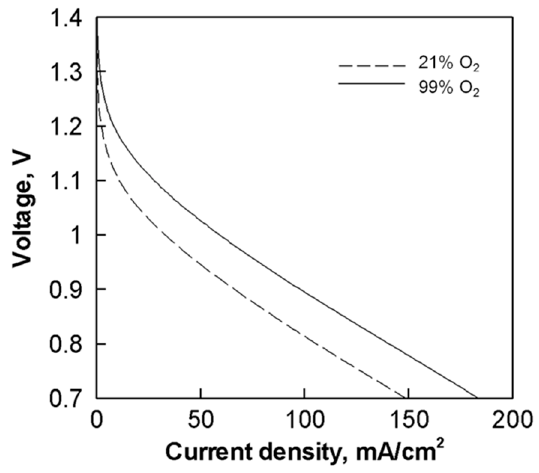
Figure 7. Effect of oxidant concentration on cell performance.